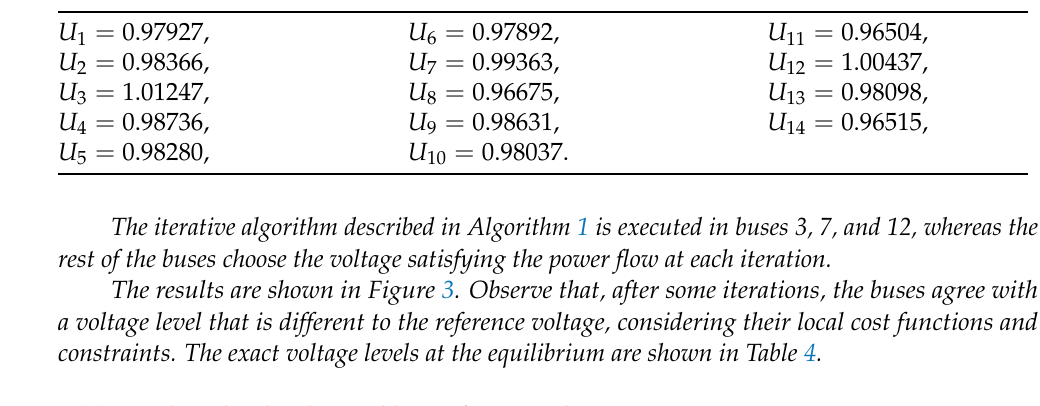
Table 4. Voltage level at the equilibrium for Example 1.